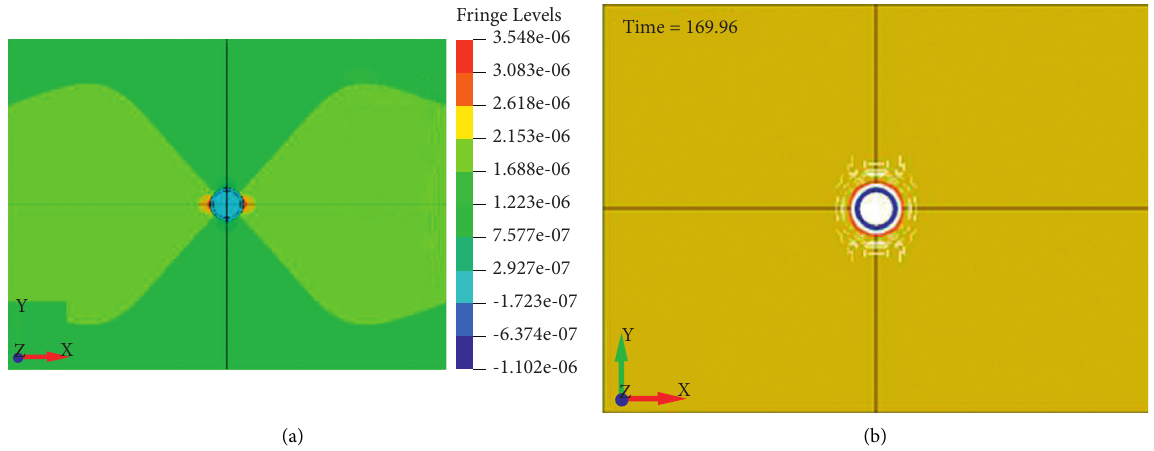
Figure 11: The stress distribution and damage zone around a blast hole under unidirectional in situ stress (Case II: P 1 � 0.5MPa). (a) Distribution of tensile and compressive stress. (b) Damage zone around a blast